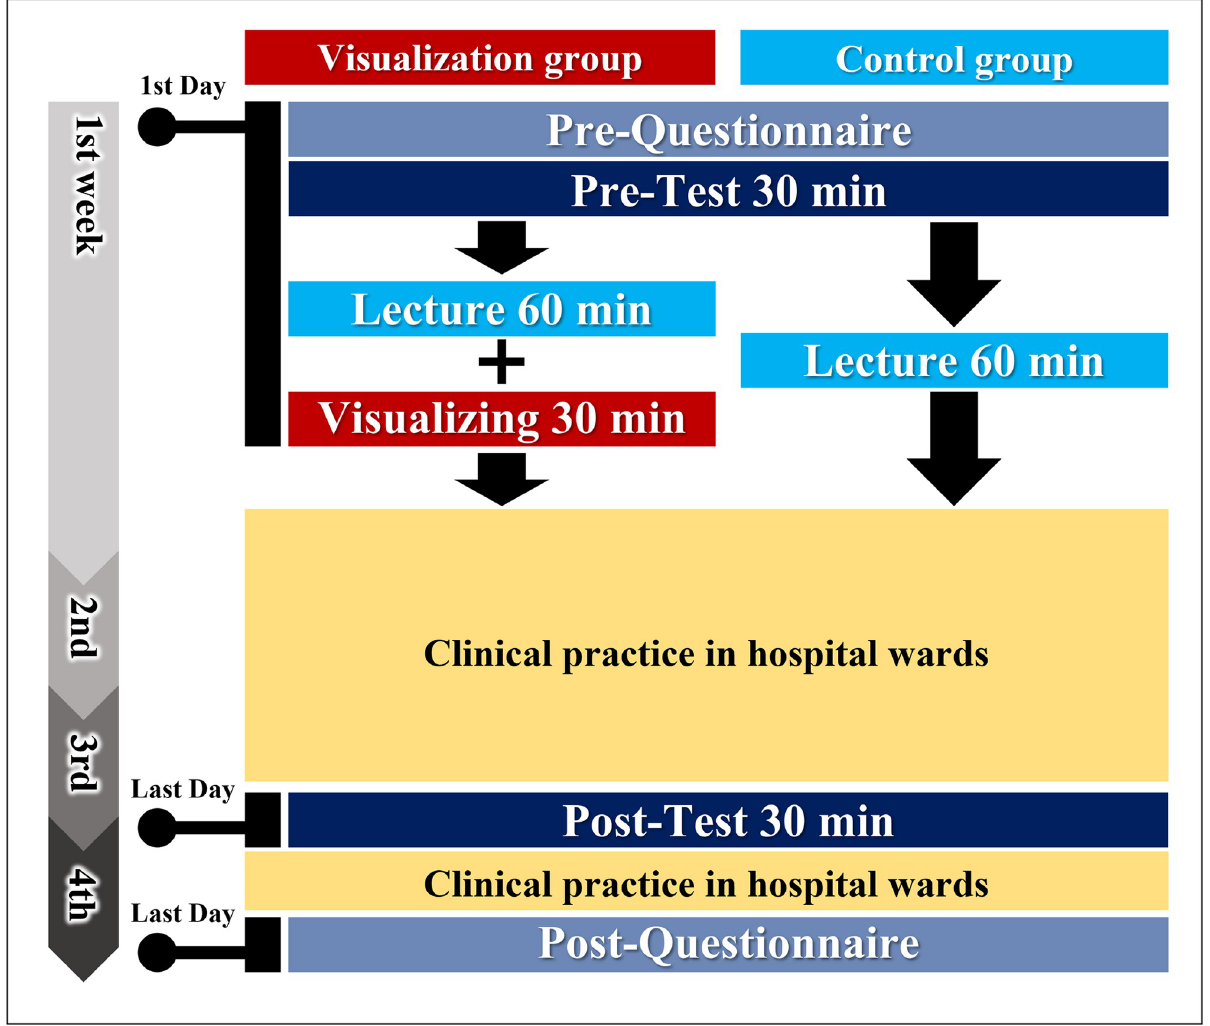
Fig 3. Protocol for lung auscultation education and questionnaire and test regarding lung auscultation.